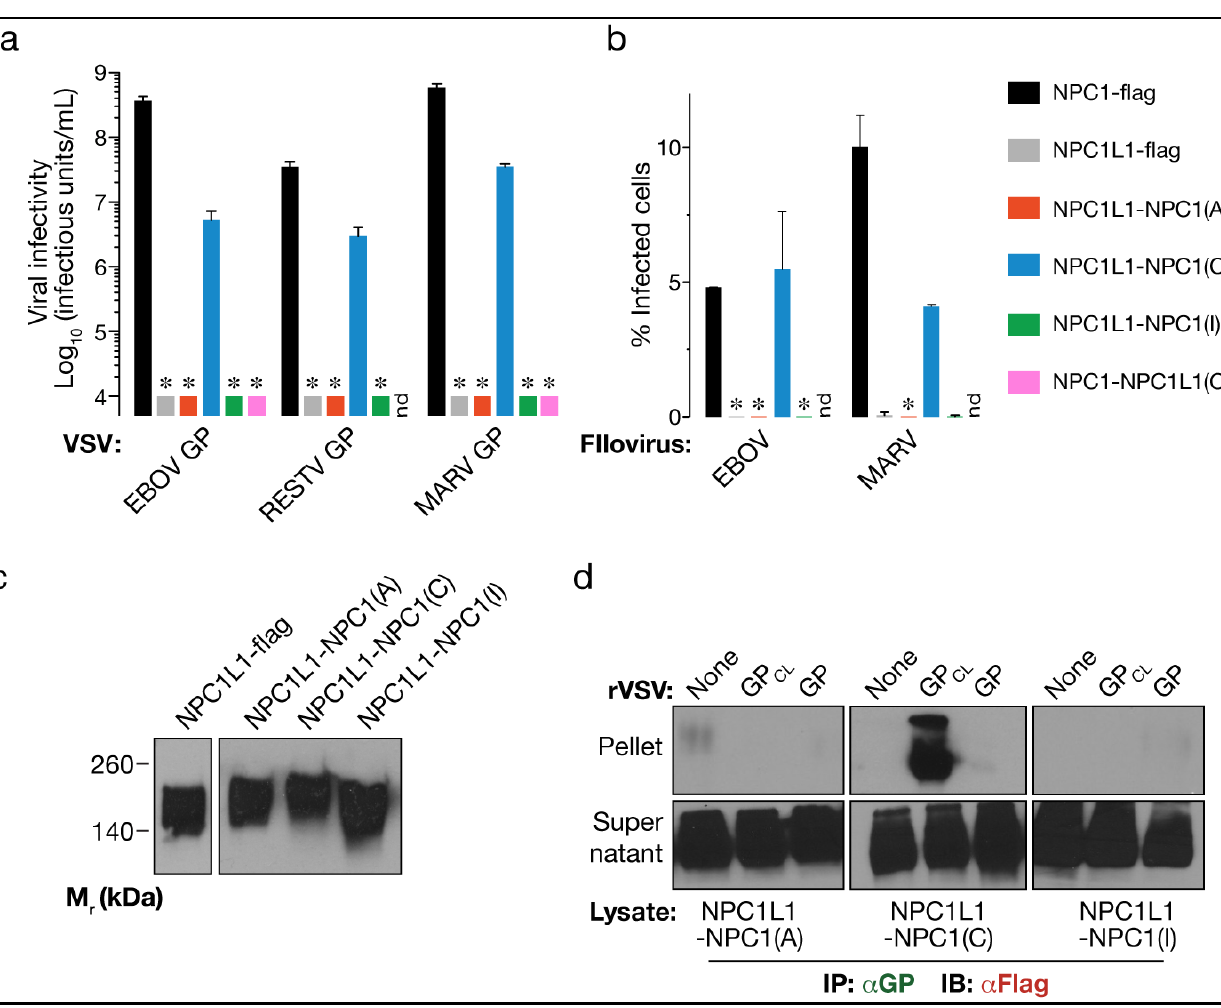
Figure 2. NPC1’s domain C converts NPC1L1 into a highly effective filovirus receptor. (a-b) Infection of CT43 cells expressing NPC1-flag, NPC1L1-flag, or the indicated flag- tagged NPC1L1-NPC1 chimeras by VSV pseudotypes bearing filovirus glycoproteins (a) or authentic filoviruses. nd, not determined. (b). Asterisks indicate data points at or below the limit of detection. (c) Expression of NPC1L1-flag and the indicated flag-tagged NPC1L1-NPC1 chimeras in CT43 cells was detected by immunoblotting with an anti-flag antibody. (d) Co-immunoprecipitation of NPC1L1-NPC1 chimeras by EBOV GP was performed as described in Fig.